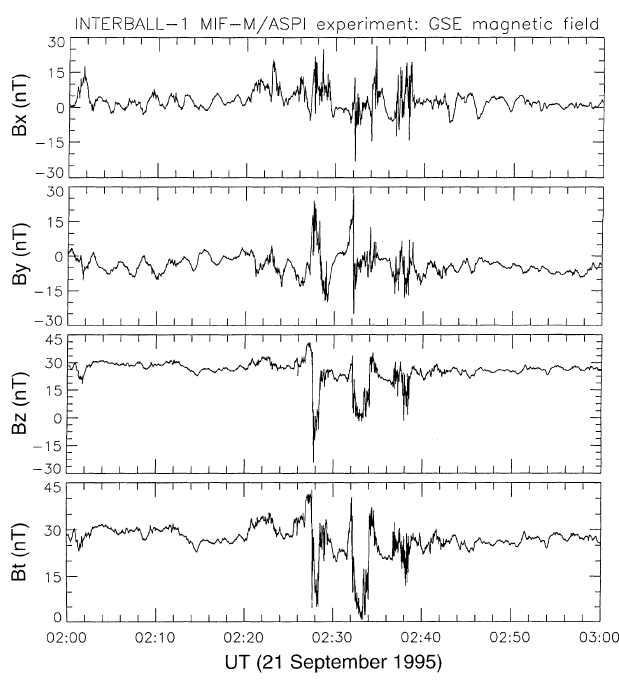
Fig. 8. Low-latitude boundary crossing 21 September 1995. GSE frame-of-reference magnetic field components and total value